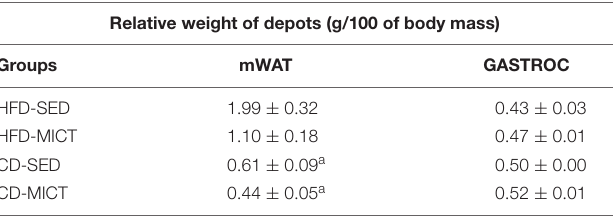
TABLE 2 | Relative weight of depots (g/100 BM). Relative weight of depots (g/100 of body mass)